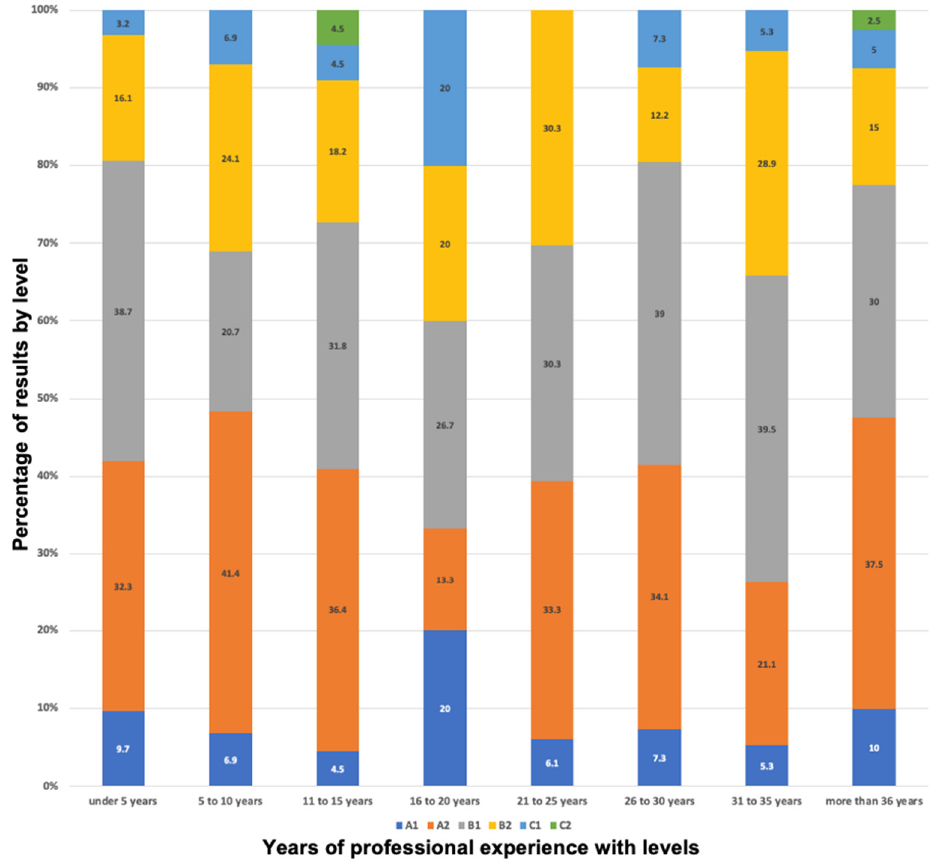
Figure 9. Distribution by level and teaching experience.